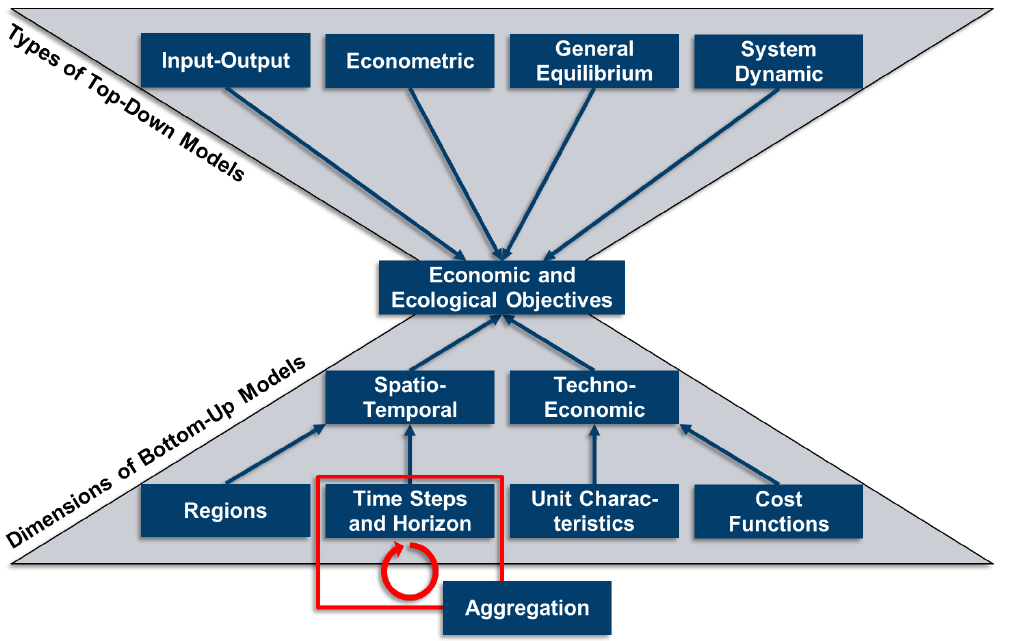
Figure 1. Classification of energy system models (ESMs), the sub-dimensions of bottom-up models and the scope of the review on time series aggregation (TSA).